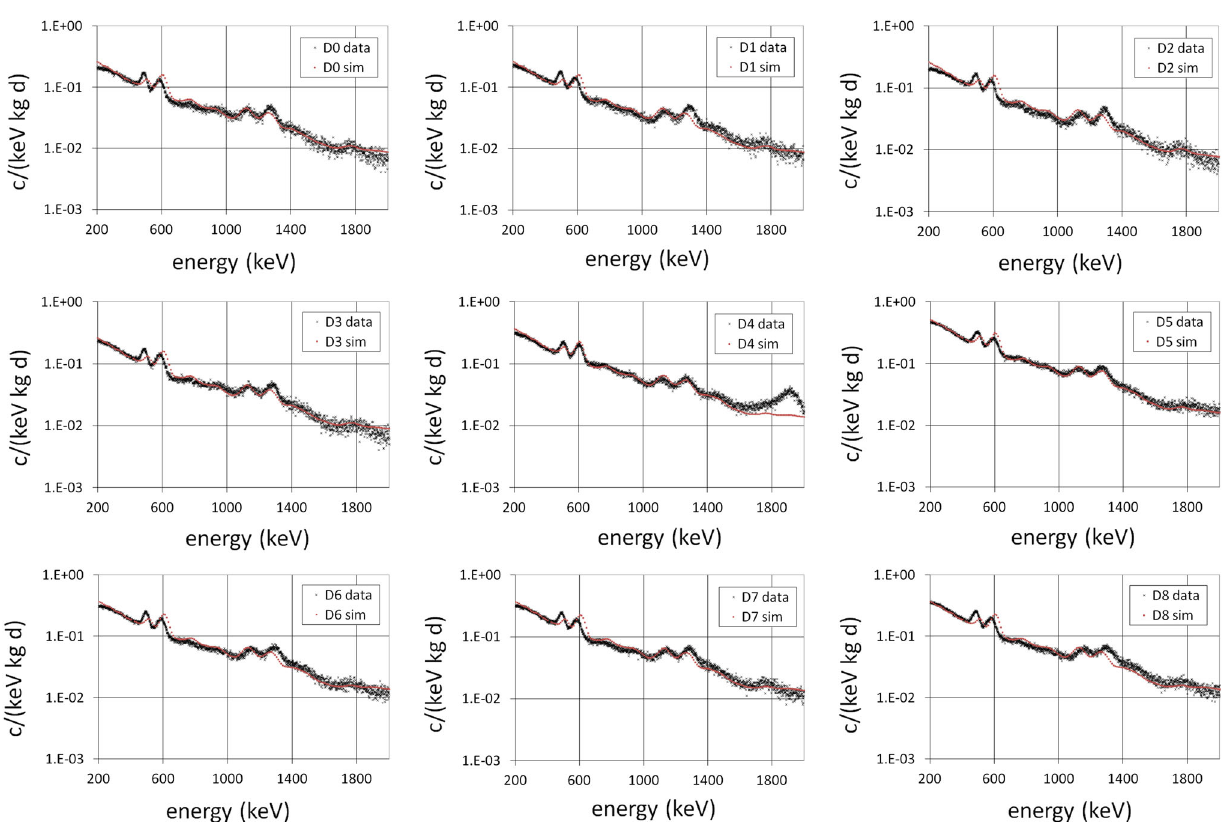
Fig. 9 Comparison of the coincidence energy spectra measured in the first year of data taking for each detector with the corresponding back- ground model summing all the simulated contributions, including the effect of Cerenkov emissions from the radioactivity of PMTs. Note that